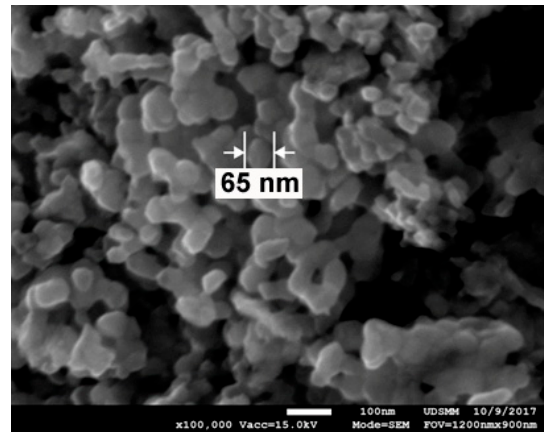
Figure 1. SEM image of LaCoO 3 annealed at 600 °C for 9 h.